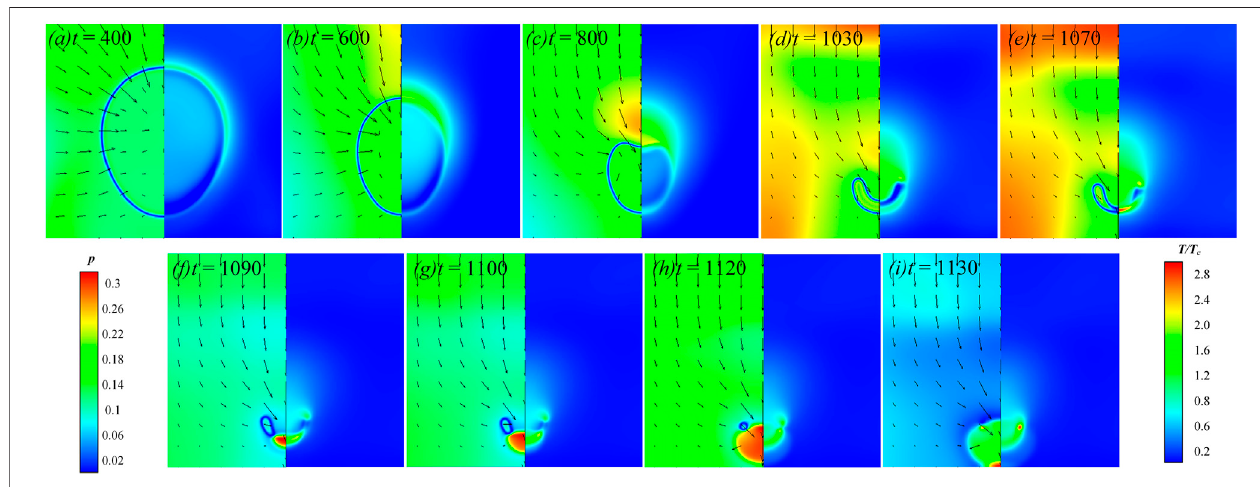
FIGURE 7 | Temperature, pressure, and velocity fi eld evolutions of cavitation bubble ( R 0 = 80, λ = 1.2, and Δ p = 0.0853). (A) Temperature (right), pressure, and velocity fi eld(left)ofcavitationbubblecollapsenearawallatt=400 ts; (B) Temperature(right),pressure,andvelocity fi eld(left)ofcavitationbubblecollapsenearawallat t = 600 ts; (C) Temperature (right), pressure, and velocity fi eld (left) of cavitation bubble collapse near a wall at t = 800ts; (D) Temperature (right), pressure, and velocity fi eld (left) of cavitation bubble collapse near awall at t = 1030 ts; (E) Temperature (right), pressure, and velocity fi eld (left) of cavitation bubble collapse near a wall at t =1070 ts; (F) Temperature(right),pressure,andvelocity fi eld(left)ofcavitationbubblecollapsenearawallat t =1090 ts; (G) Temperature(right),pressure,andvelocity fi eld (left) of cavitation bubble collapse near a wall at t = 1100ts; (H) Temperature (right), pressure, and velocity fi eld (left) of cavitation bubble collapse near a wall at t = 1120 ts; (I) Temperature (right), pressure, and velocity fi eld (left) of cavitation bubble collapse near a wall at t = 1130 ts.